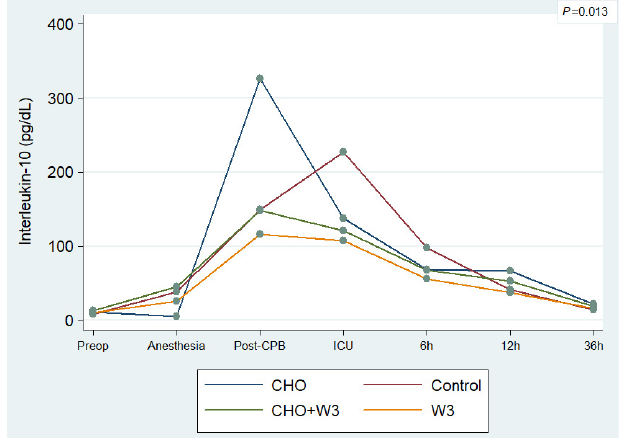
Fig. 8 - Average level of the IL-10 inflammatory marker per group, taken from seven serial blood